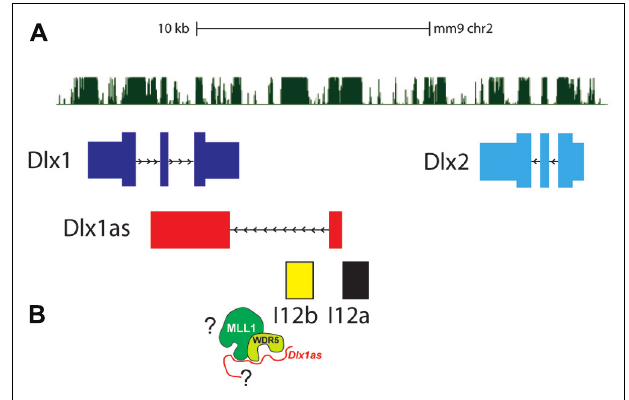
FIGURE 3 |The Dlx1/2 bigene cluster. (A) Dlx1 (dark blue) and Dlx2 (light blue) are oriented in an inverted configuration separated by two enhancers, I12a (black) and I12b (yellow).The lncRNA Dlx1as transcript (red) consists of two “exons” that are spliced and polyadenylated. (B) Whether Dlx1as is a key component of MLL1 function at the Dlx1/2 locus is not